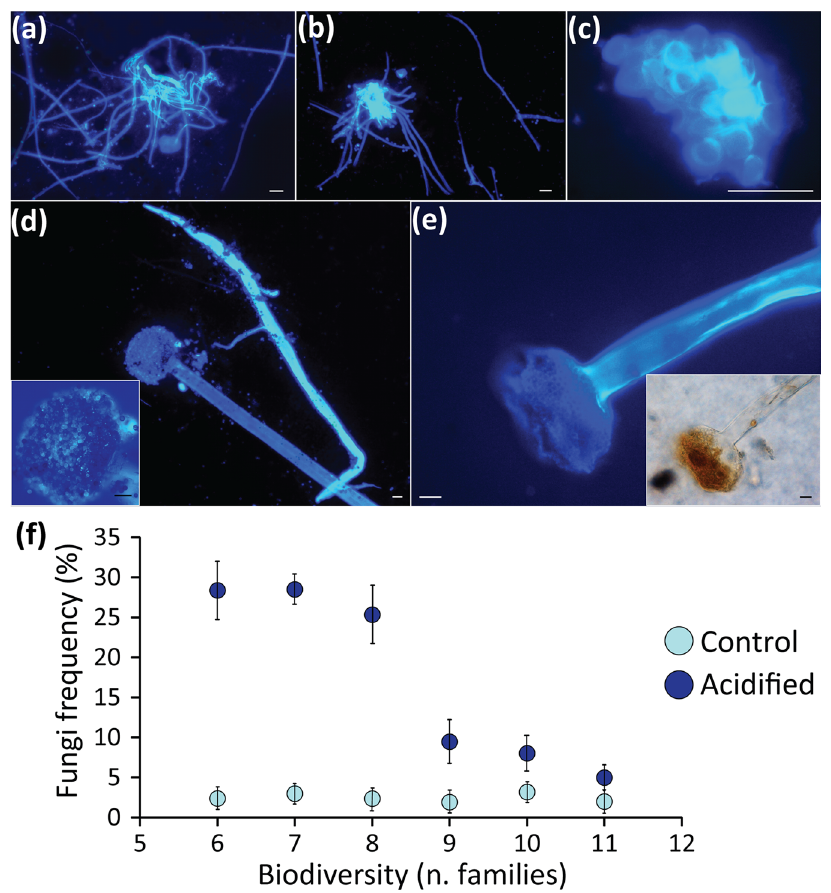
Figure 5. Impact of acidification on unicellular fungi. Reported are microscopy images, illustrating examples of fungal structures colonizing the surface of the coralligenous assemblages tested in the present study. ( a , b ) fungal hyphae with septa and filamentous branching; ( c ) cluster of fungal spores; ( d , e ) sporangia with enlarged highlights showing details of the spores under epifluorescence or normal light microscopy (scale bars, 10 µ m). The scatter plot ( f ) shows the relationships between biodiversity (as number of different families contained in the natural coralligenous assemblages tested) and the proliferation of fungi in acidified and non-acidified (control) mesocosms. Reported are average values and